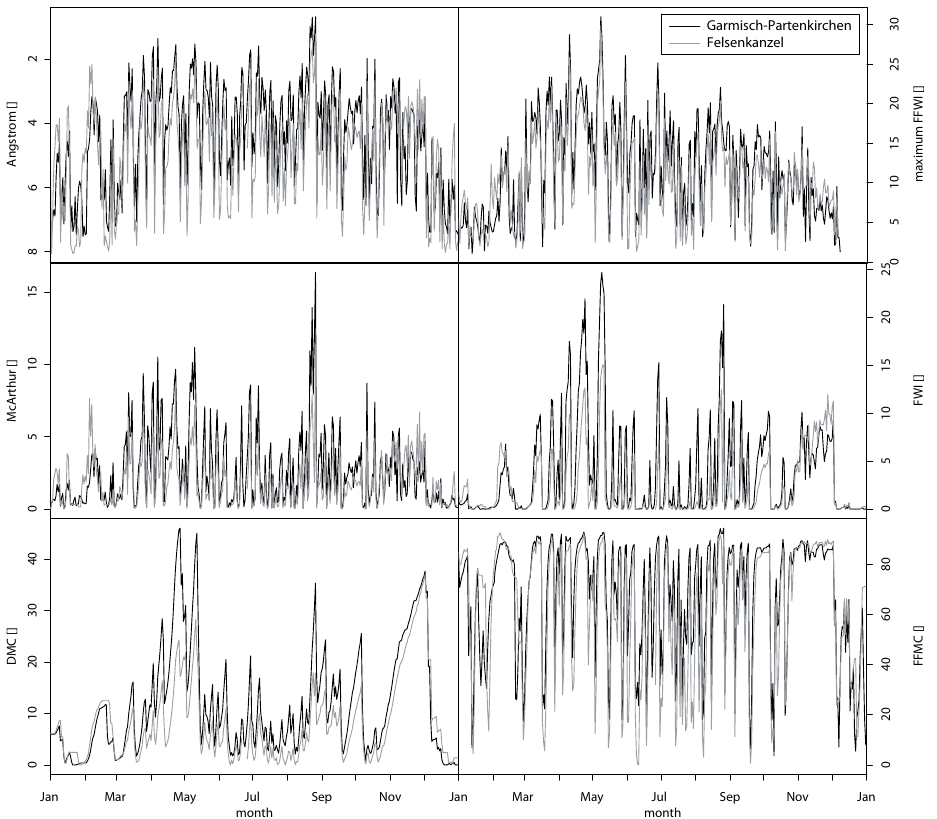
Fig. 6. Selected fire danger indices at Garmisch-Partenkirchen (black line) and Felsenkanzel (grey line) stations in 2011. Note that for the Angstrom index, the y axis has been inverted since high values represent low fire danger and low values represent high fire danger, in contrast to all other indices. For fire occurrence information, refer to Sect.